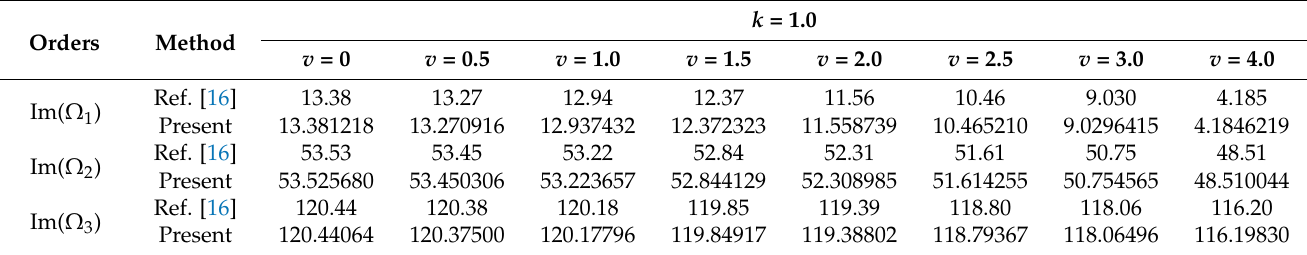
Table 3. The calculated values of the first three dimensionless natural complex frequencies of the FGM simply supported beam under different axial motion velocities v ( k =